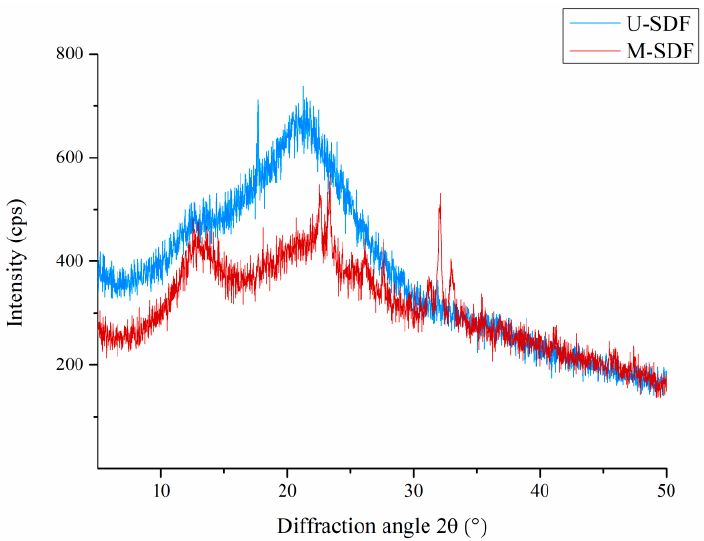
Figure 3. XRD pa tt ern of the U-SDF and M-SDF. Figure 3. XRD pattern of the U-SDF and